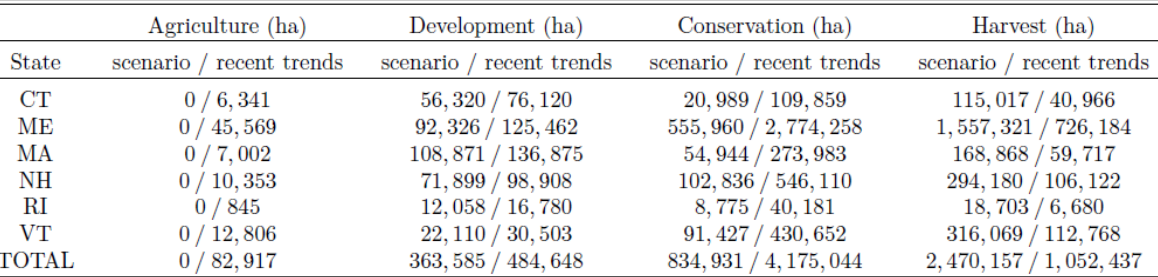
Table A3.3. New Transitions 2010-2060 (Growing